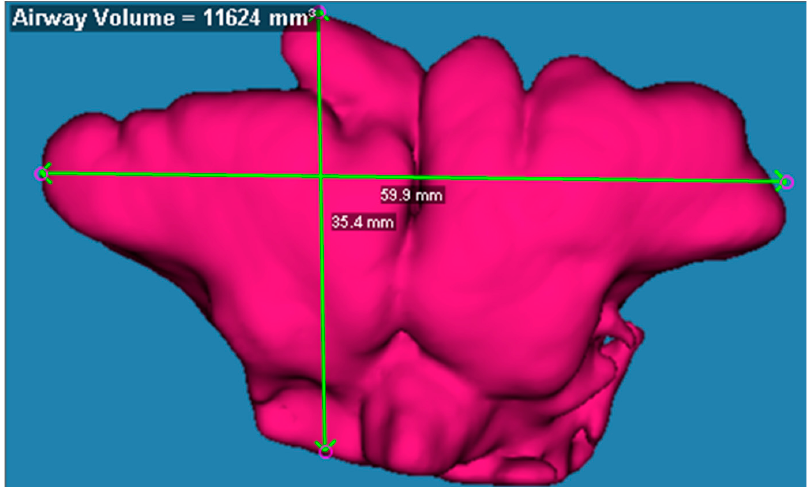
Figure 1. A representative image of the frontal